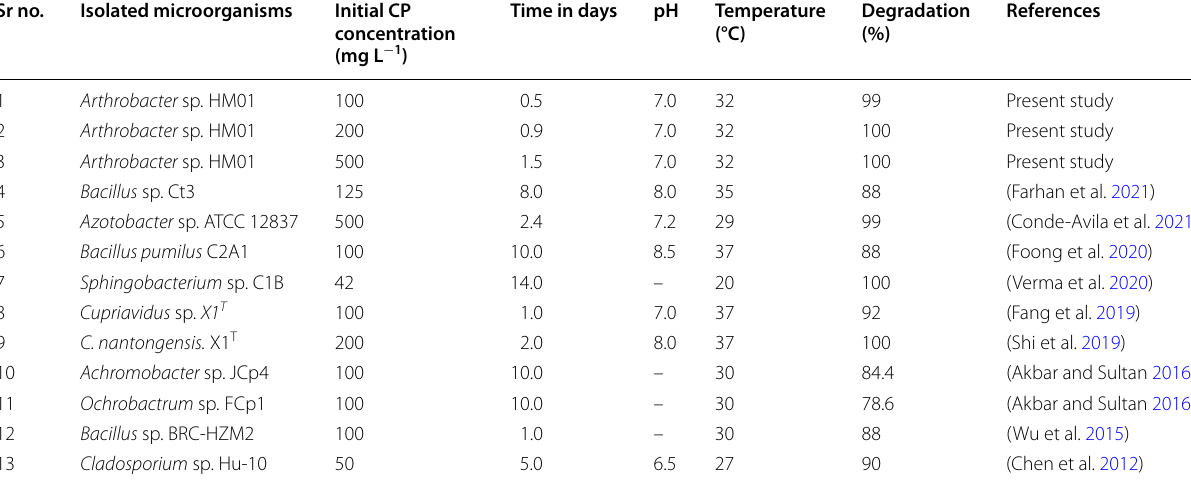
Table 1 CP degradation rate of isolate HM01 and other reported microorganisms Sr